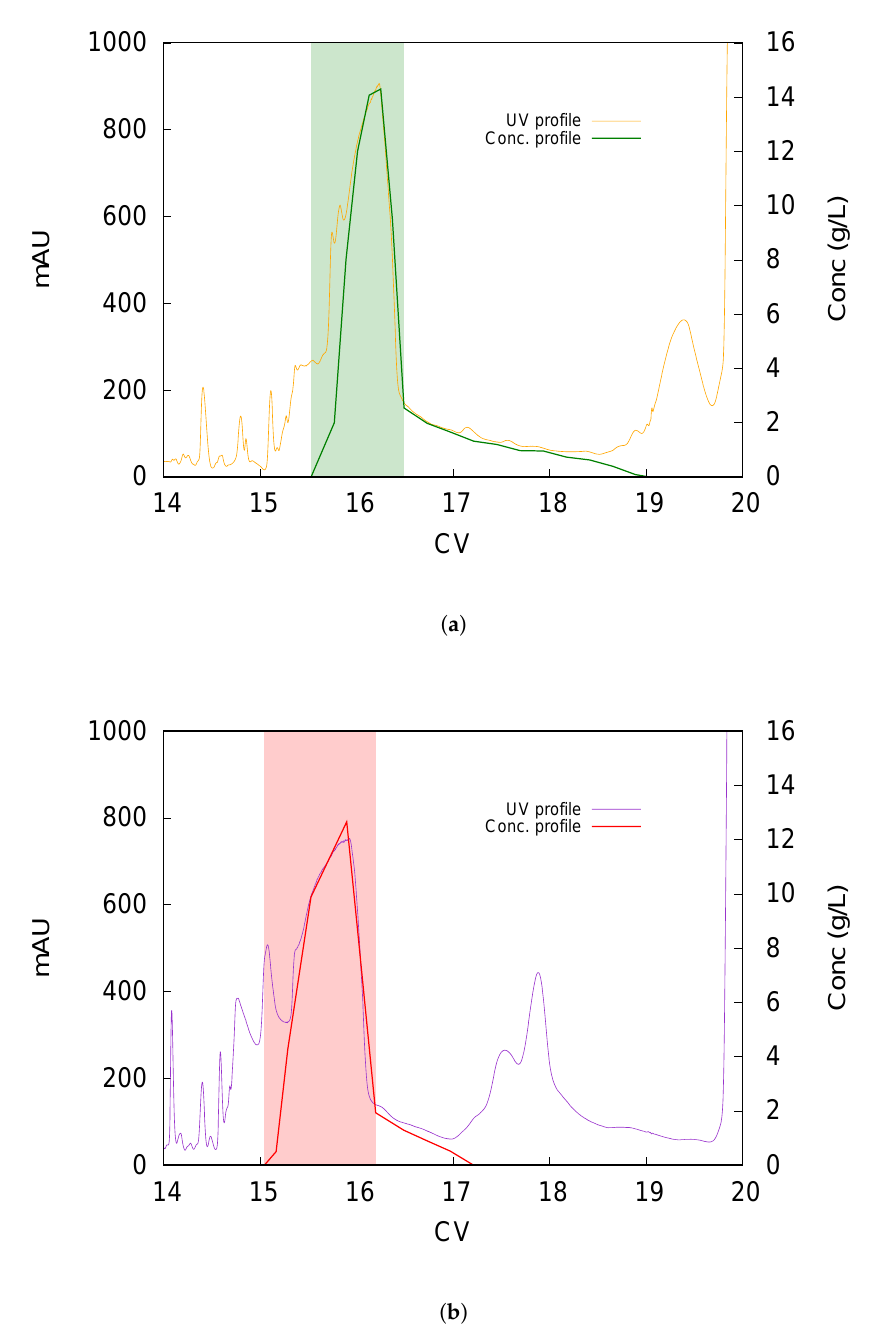
Figure 1. UV profile and concentration profile of the target peptide using ( a ) a C8 column and ( b ) a mixed- mode column. The coloured regions represent the pooled windows (see the text for further